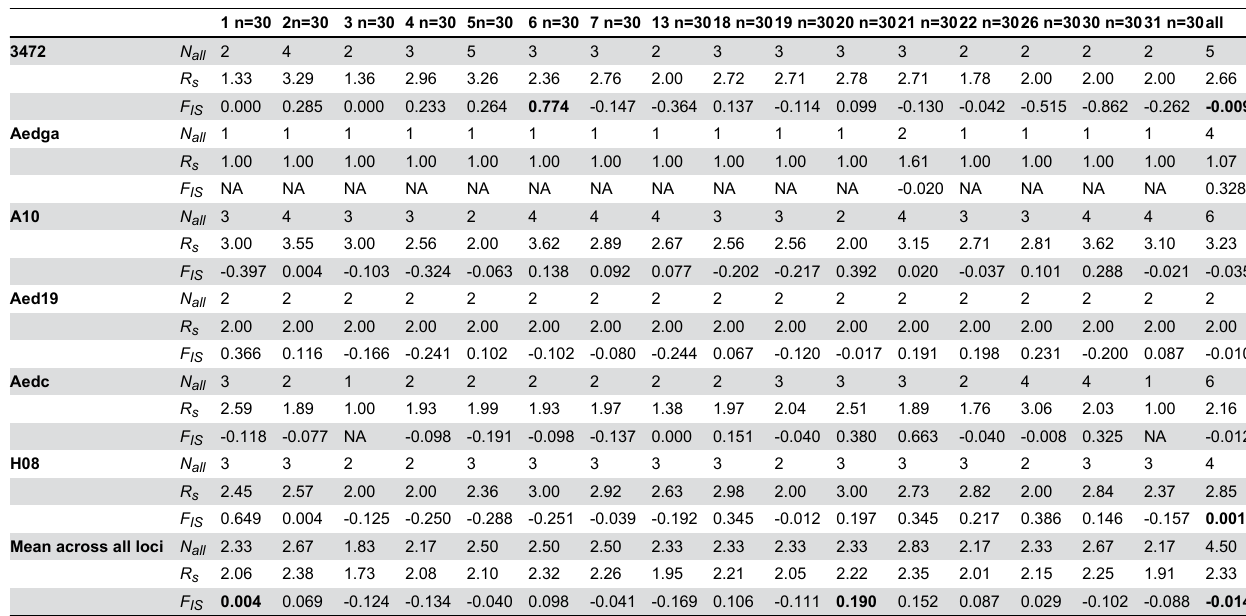
Table 2. Genetic variability and goodness of fit to Hardy-Weinberg expectation in Ae. aegypti populations at the macro- geographic level in